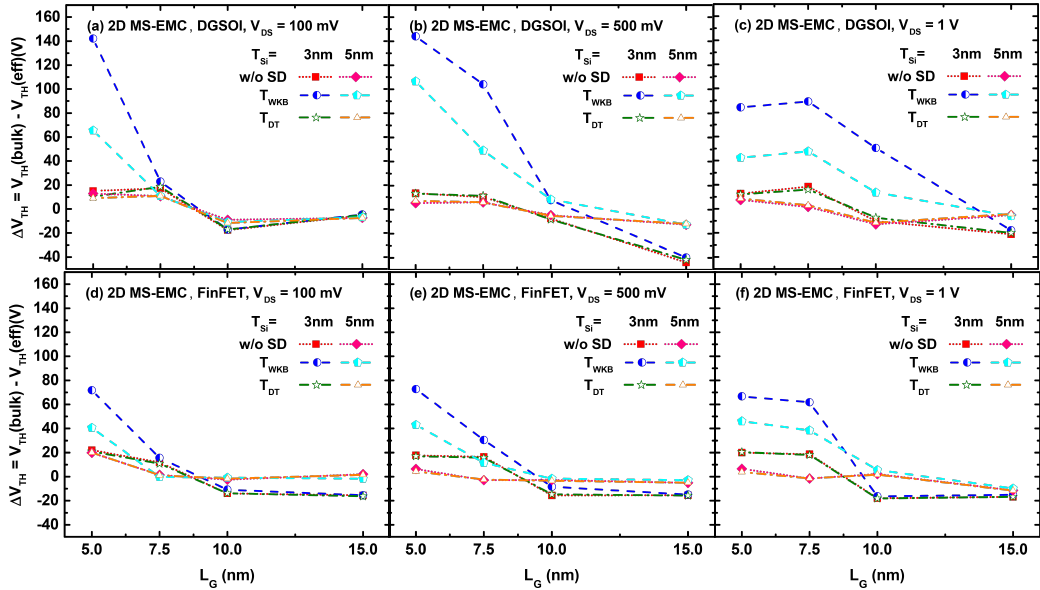
Figure 7. ∆ V TH as a function of the gate length in the DGSOI and FinFET devices with silicon thickness T Si = 3–5 nm at V DS = 100 mV ( a , d ), V DS = 500 mV ( b , e ), and V DS = 1 V ( c , f ), considering the three 2D MS-EMC combinations: without any tunneling module and with both S/D tunneling modules using T WKB (E x ) and T DT (E x )